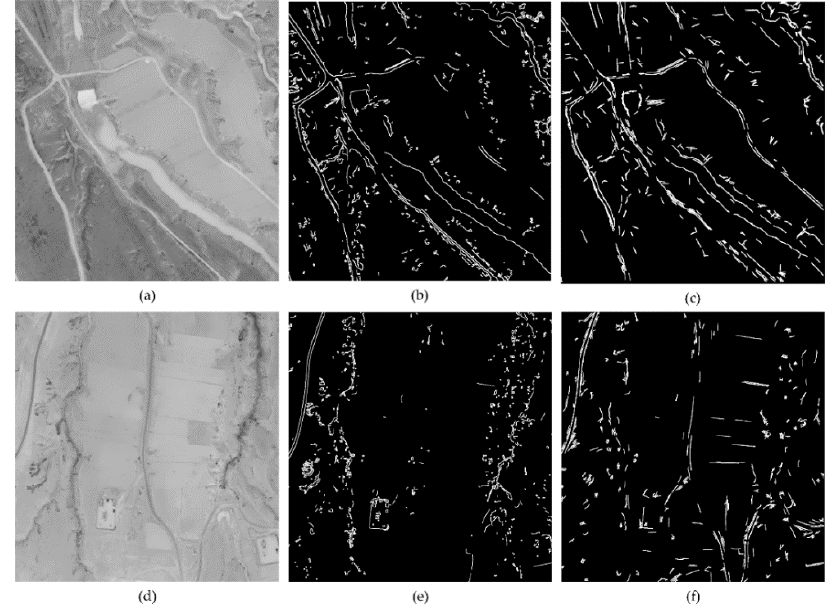
Figure 4. Edge-detection comparison. ( a , d ) Original image where edge information is not so conspicuous; ( b , e ) result by canny algorithm, lower- and upper-threshold parameters were set to 50 and 100, respectively; ( c , f ) erged map by eight orientation filter results ( λ = 3, ϕ = 0, σ = 1.7, κ = 0.3